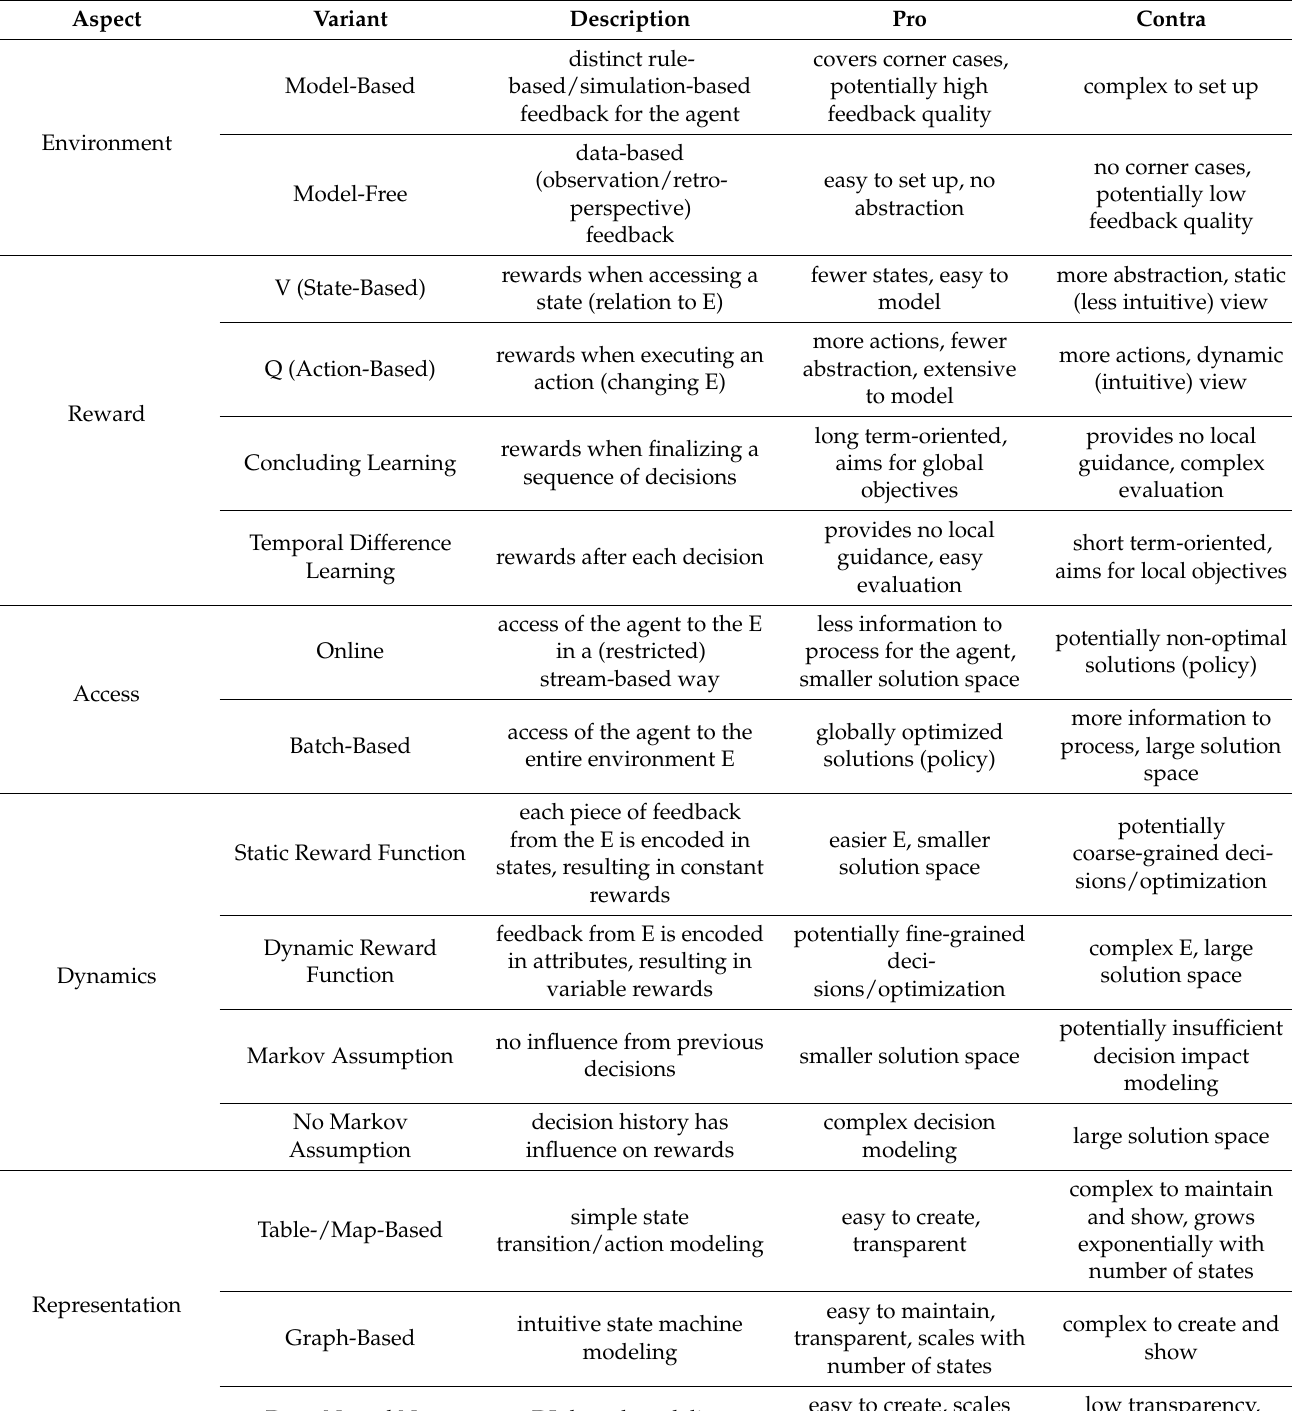
Table 2. Variants and methodologies of reinforcement